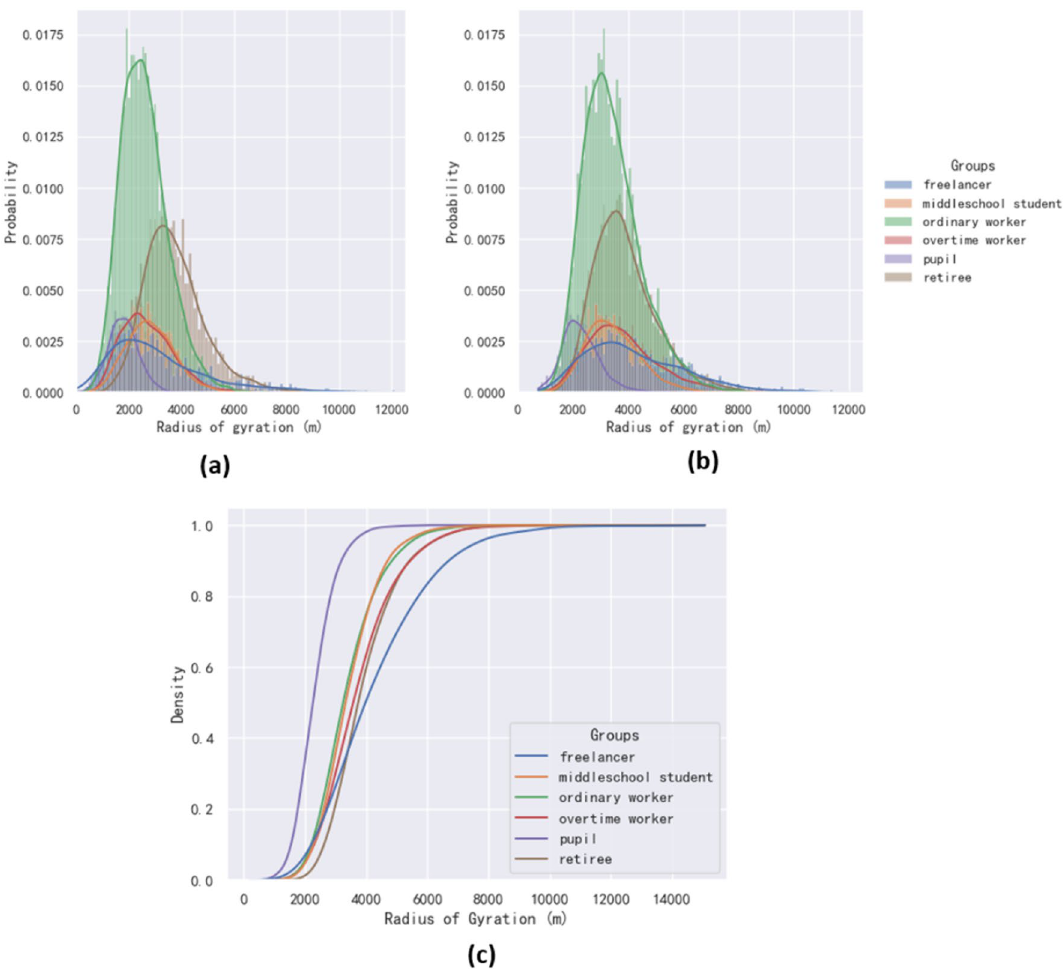
Figure 7. The radius of gyration of diverse groups on working days ( a ) and non-working days ( b ), and cumulative distribution function (CDF) of the radius of gyration for each groups ( c ). ( a ) The data from day1 to day4 were used to calculate the radius of gyration for working days. ( b ) The data from day5 and day6 were selected to calculate the radius of gyration for non-working days. ( c ) The data from day1 and day9 were selected to calculate the Cumulative distribution function (CDF) of the radius of